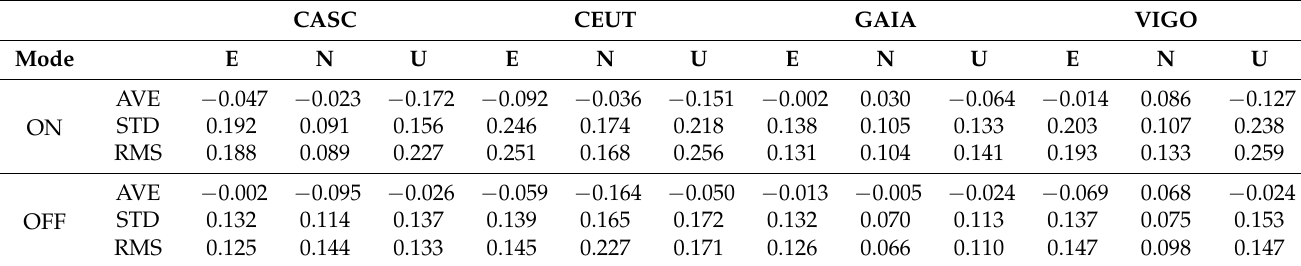
Table 8. Test 1 statistics comparing the flight mode ON &